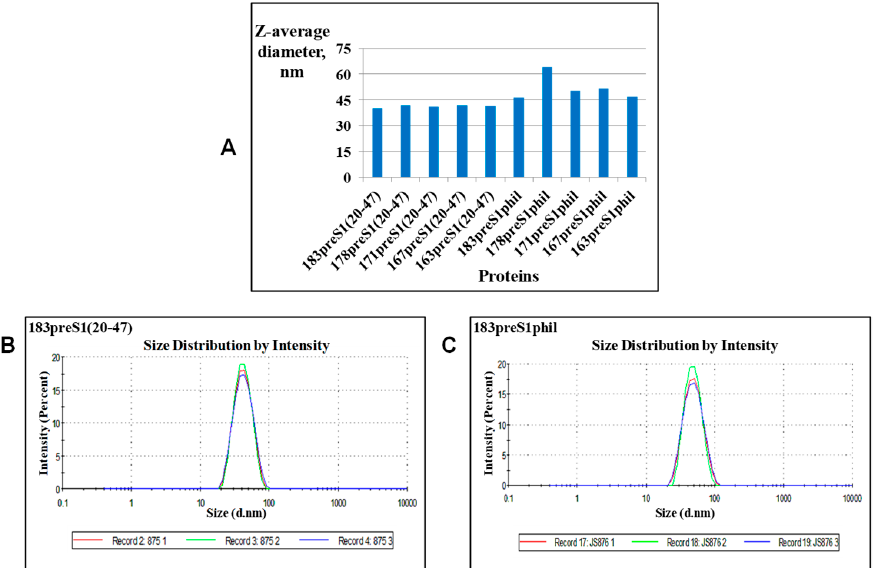
Figure 7 . DLS analysis of the HBc-preS1 VLPs preparations. ( A ) Z-average of VLPs for all investigated VLP preparations. ( B , C ) Size distribution for VLPs of 183preS1(20–47) and 183preS1phil proteins, respectively.